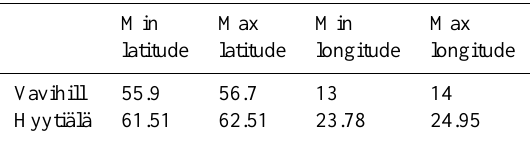
Table 2. Latitude and longitude boundaries in decimals for the in- vestigated areas. Min Max Min Max latitude latitude longitude longitude Vavihill 55.9 56.7 13 14 Hyytiälä 61.51 62.51 23.78